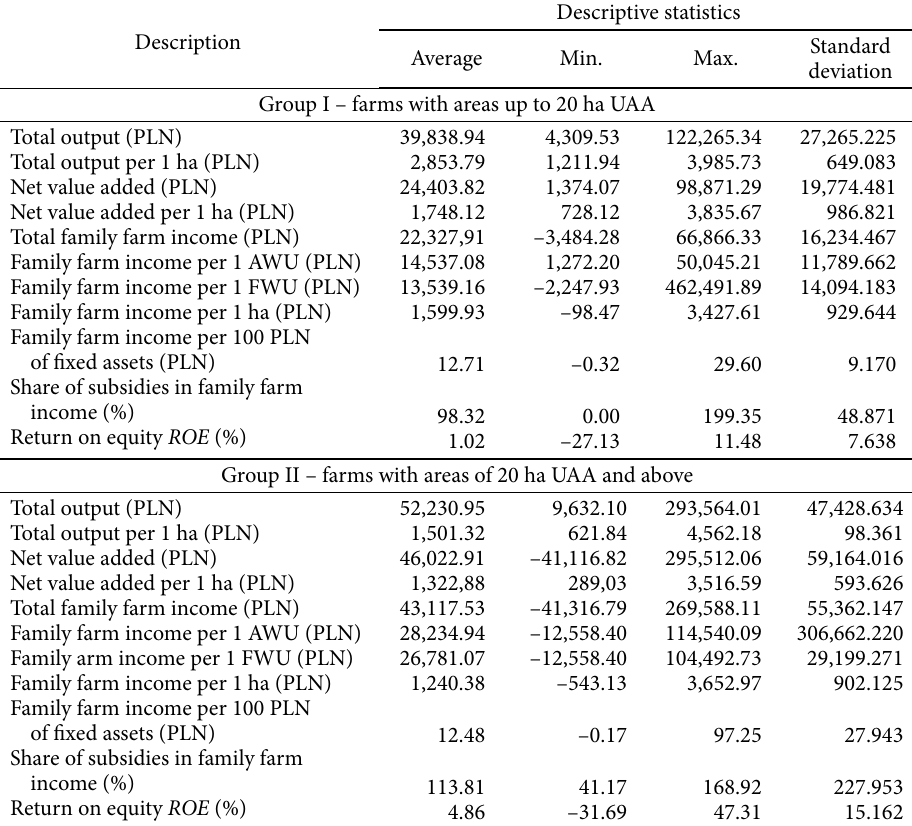
Source : own calculations based on FADN (2010)